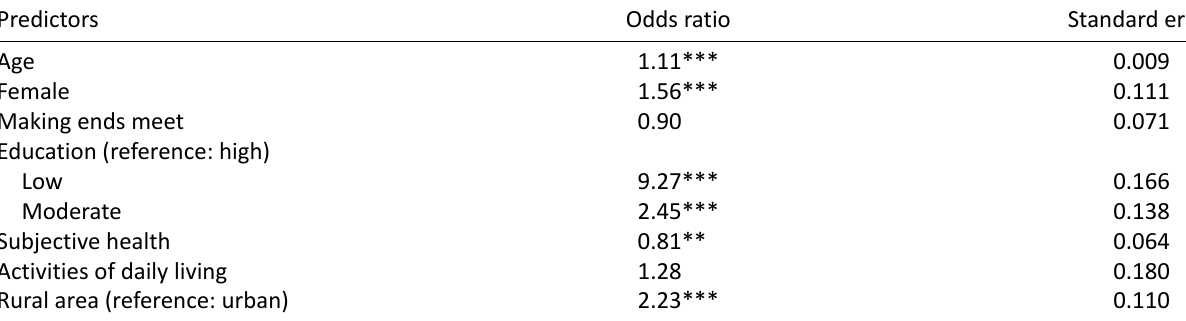
Table 2. Binary logistic regression of the predictors of Internet